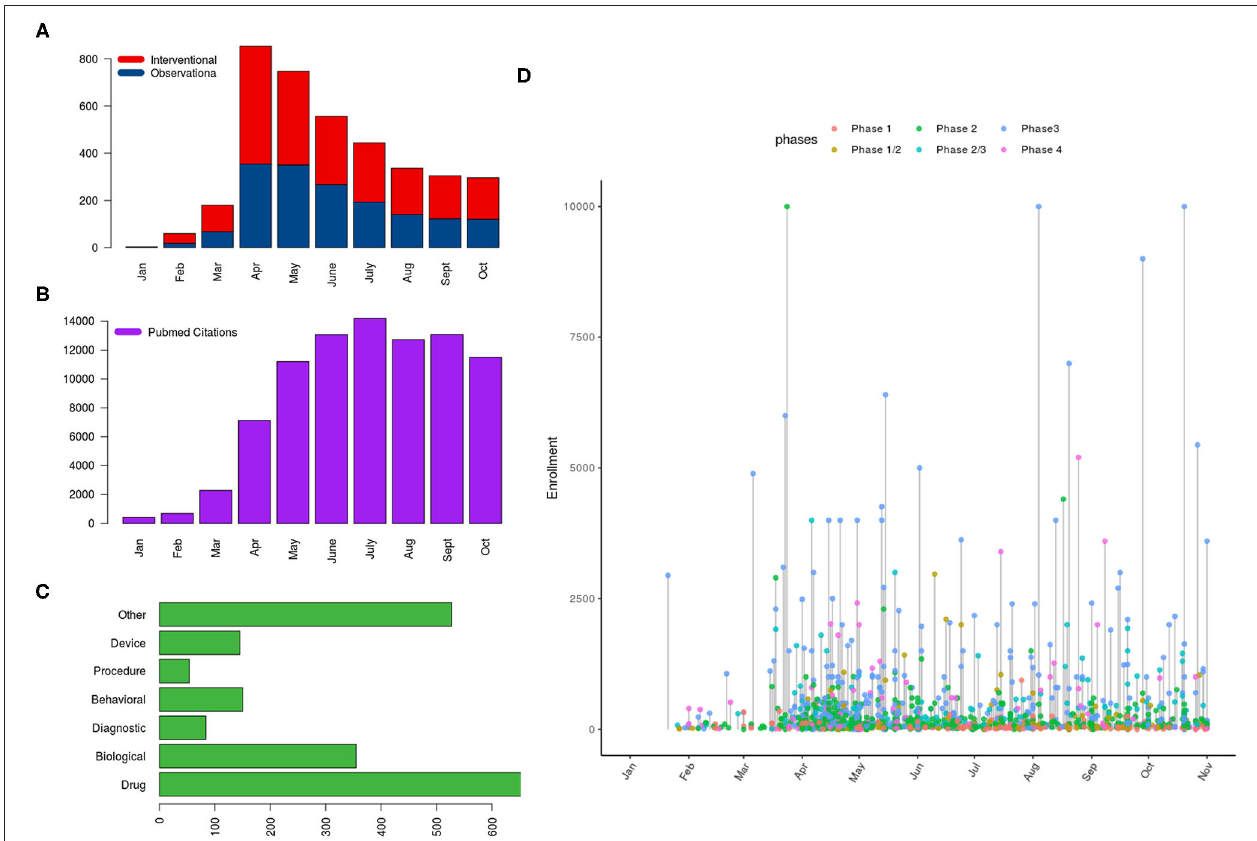
FIGURE 1 | Distribution of clinical trials registered on ClinicalTrials.gov and PubMed citations referring to COVID-19 as of October 31, 2020; the panels show (A) the distribution of studies according to type and month of posting, (B) number of PubMed citations per month, (C) the type of intervention in interventional trials, and (D) a lollipop graph showing the anticipated number of subjects to be enrolled on interventional trials with the horizontal axis indicating the date of first posting of studies (year 2020) and the y axis indicating the required number of subjects to be enrolled (capped at 10,000); color of the points indicates the phase of